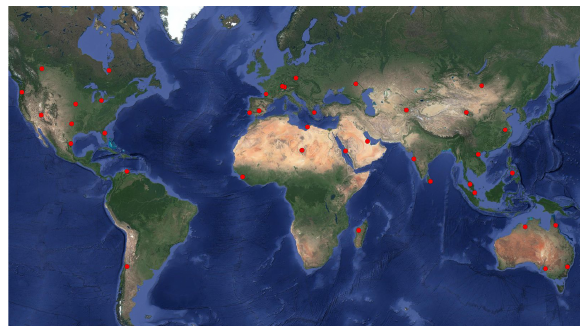
Figure 2. Geographical distribution of 40 areas selected for gathering training data.